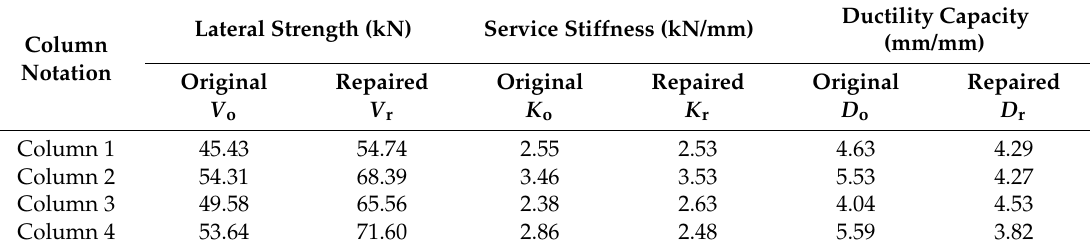
Figure 10. The hysteretic curves and the corresponding envelopes for columns: ( a ) Column O1/R1; ( b ) Column O2/R2; ( c ) Column O3/R3; ( d ) Column O4/R4. Table 3. Comparison of the results for the original and corresponding repaired columns.